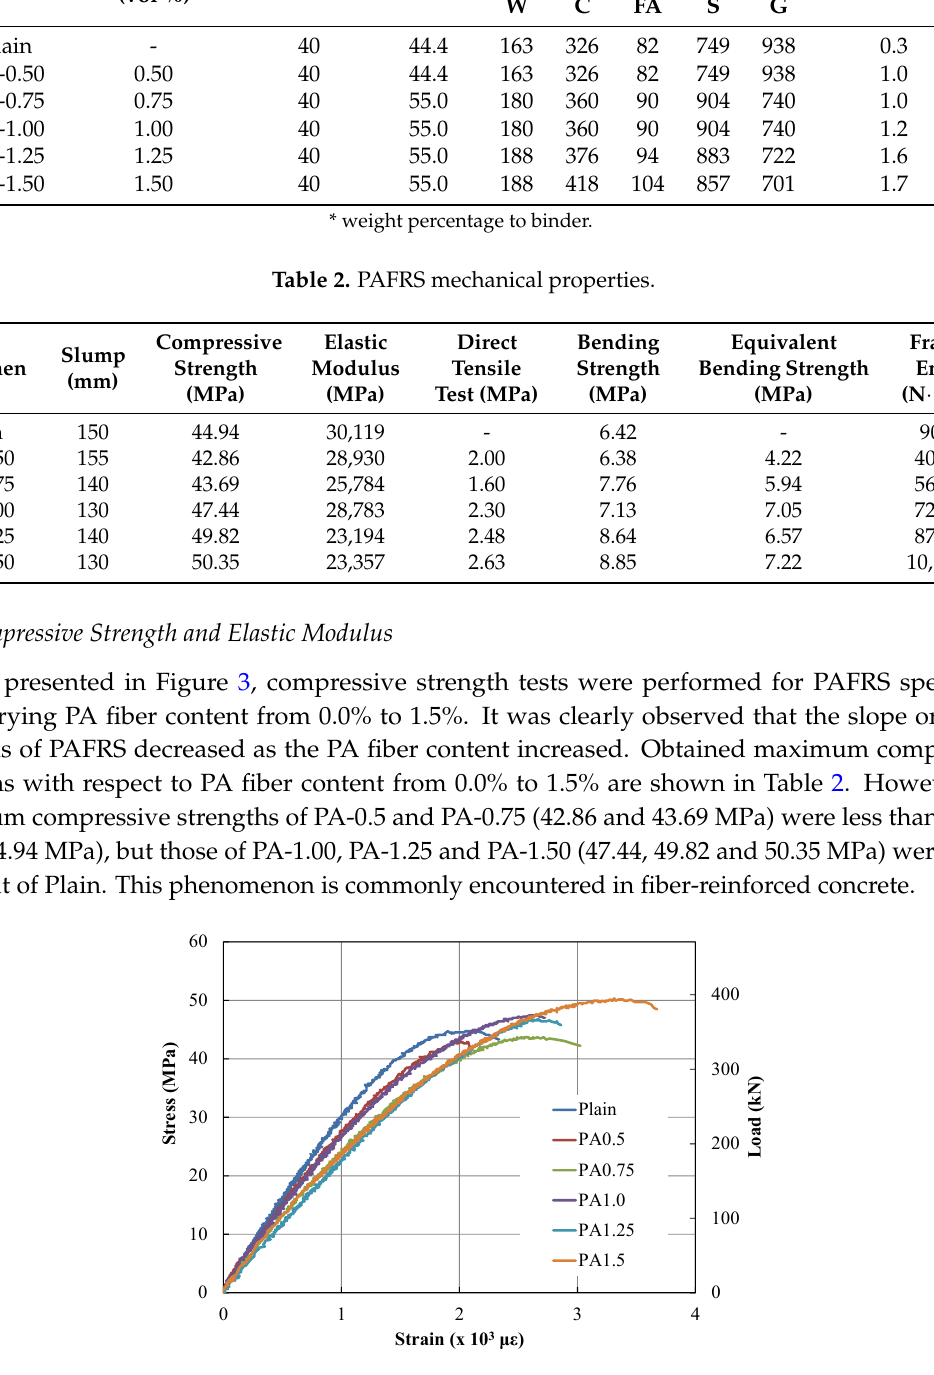
Table 1. Shotcrete mix design.